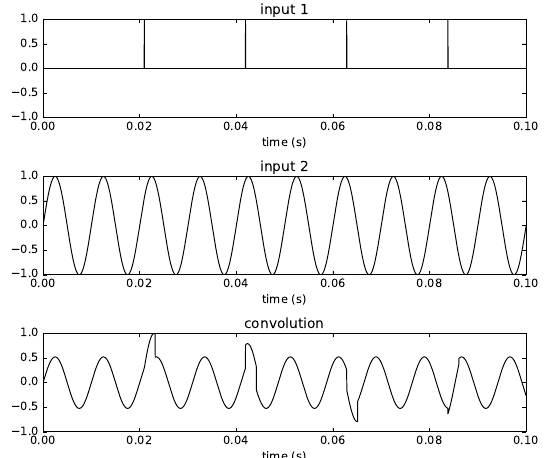
Figure 7. Time-varying convolution using a pulse train with frequency f s /924 Hz and a sine wave of 100 Hz as inputs, with filter size N = 1024 and sampling rate f s = 44,100.